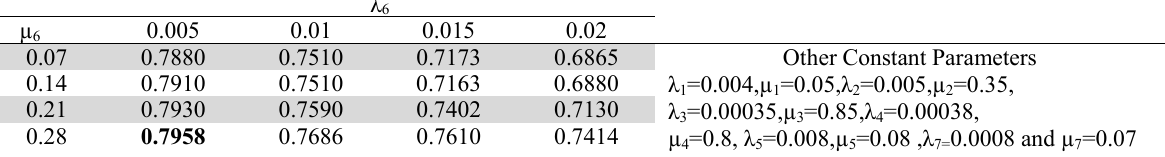
Effect of failure and repair rates of filling machine on system availability